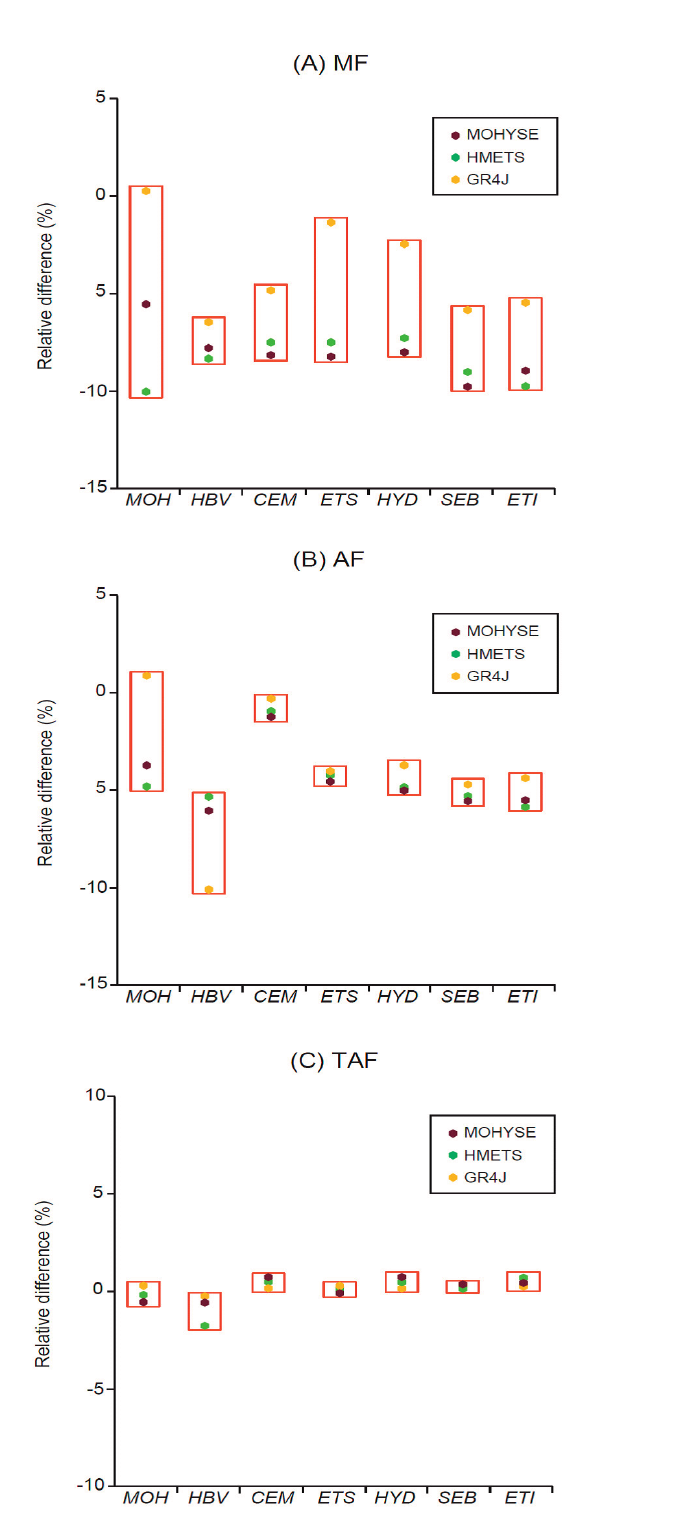
Figure 11. Relative difference (%) of the investigated indicators (the mean high flow (MF), the annual extreme flood (AF) and the timing of the annual extreme flood (TAF)) for each snow model over the 1961–2000 period. The boxes indicate the ensemble simulations and the color dots specify the three hydrological models; ( A ) MF; ( B ) AF; ( C )